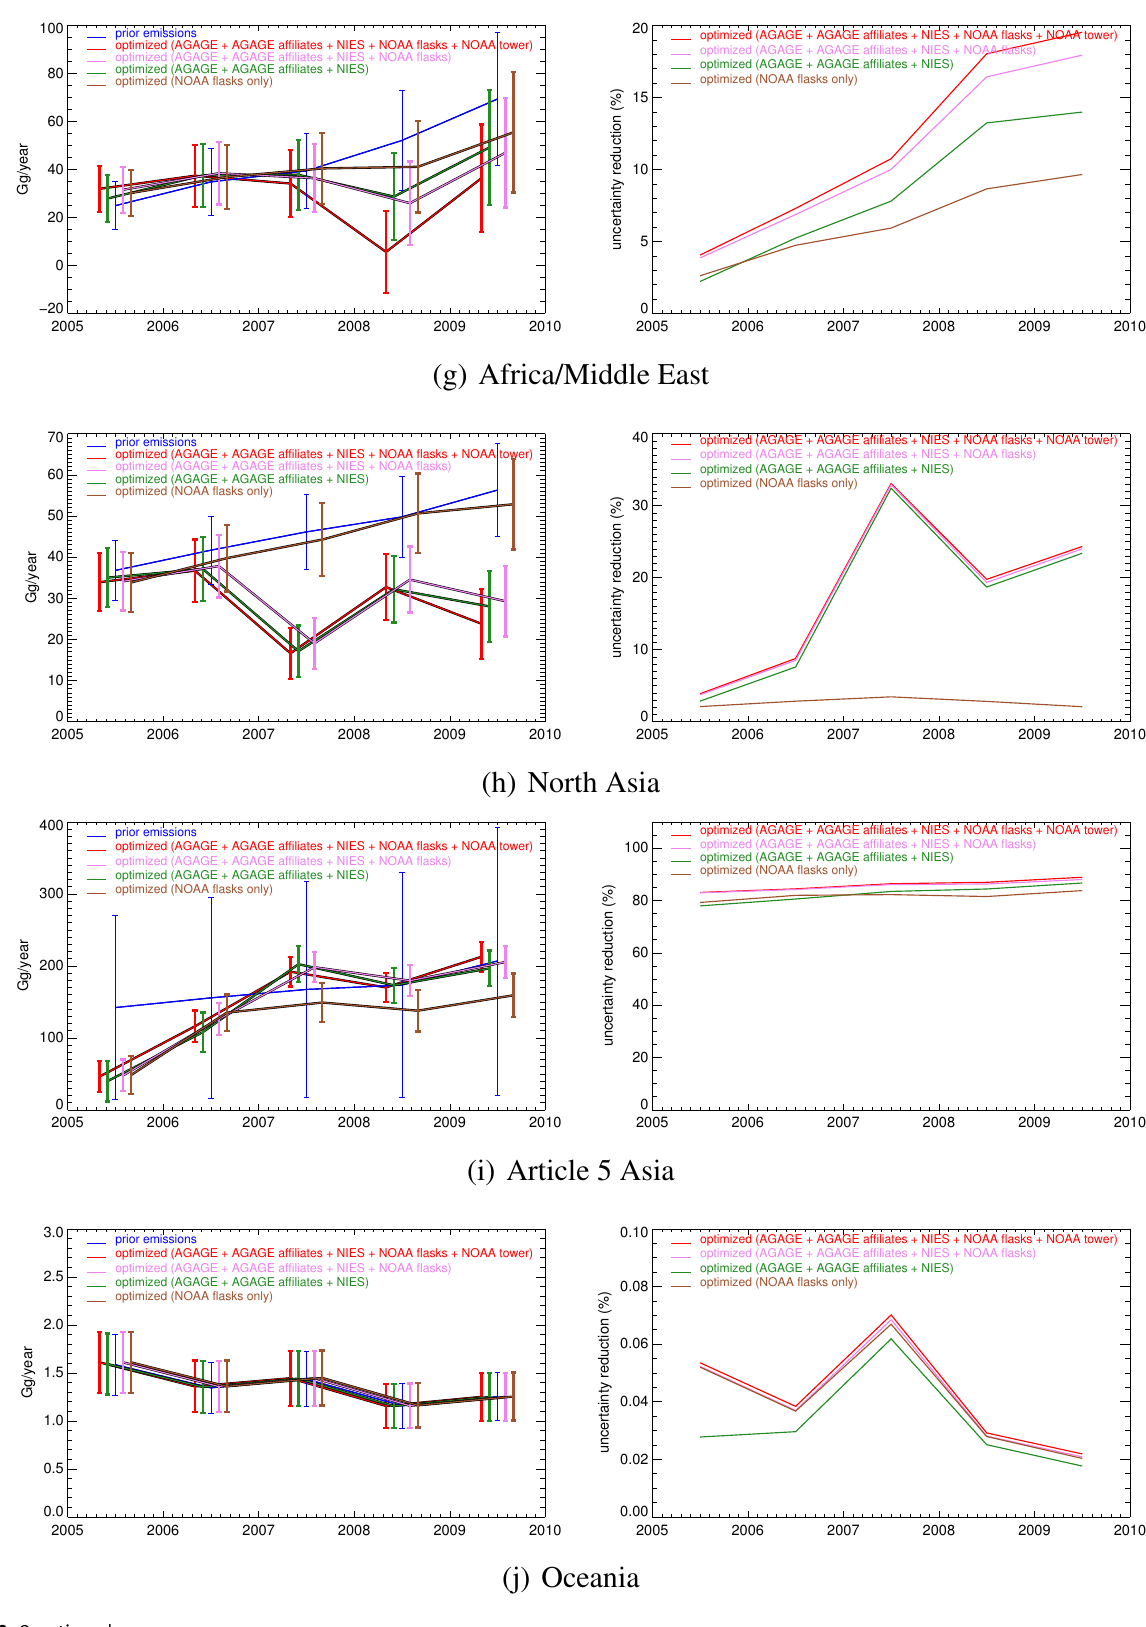
Fig. 6. Fig. 7e. Comparison of prior (blue) and optimized emissions using different sets of available observations (red: all measurements; pink: excluding NOAA tower; green: excluding all NOAA measurements; and brown: only NOAA weekly flask measurements) with respective uncer- tainty (left) and uncertainty reduction (right) in (a) Article 5 Asia and (b) Oceania for prior emis- sions (left figure only) and 4 inversion results. 35